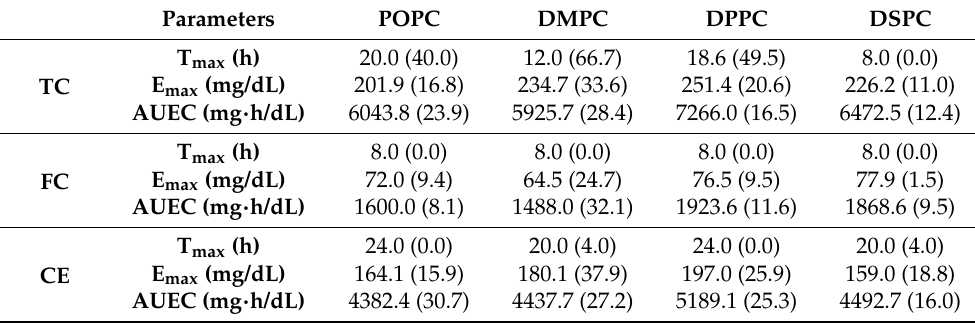
Table 3. Pharmacodynamic parameters (% CV) of total cholesterol (TC), free cholesterol (FC) and cholesterol ester (CE) after 136 µ mol/kg doses of micelles containing different PC lipids. Parameters